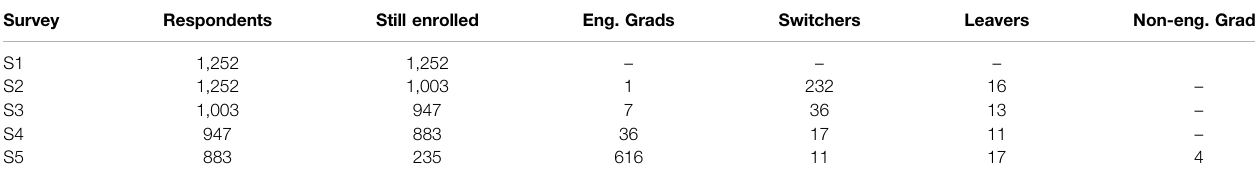
TABLE 1 | Number of Respondents, Broken down by Enrollment Status.